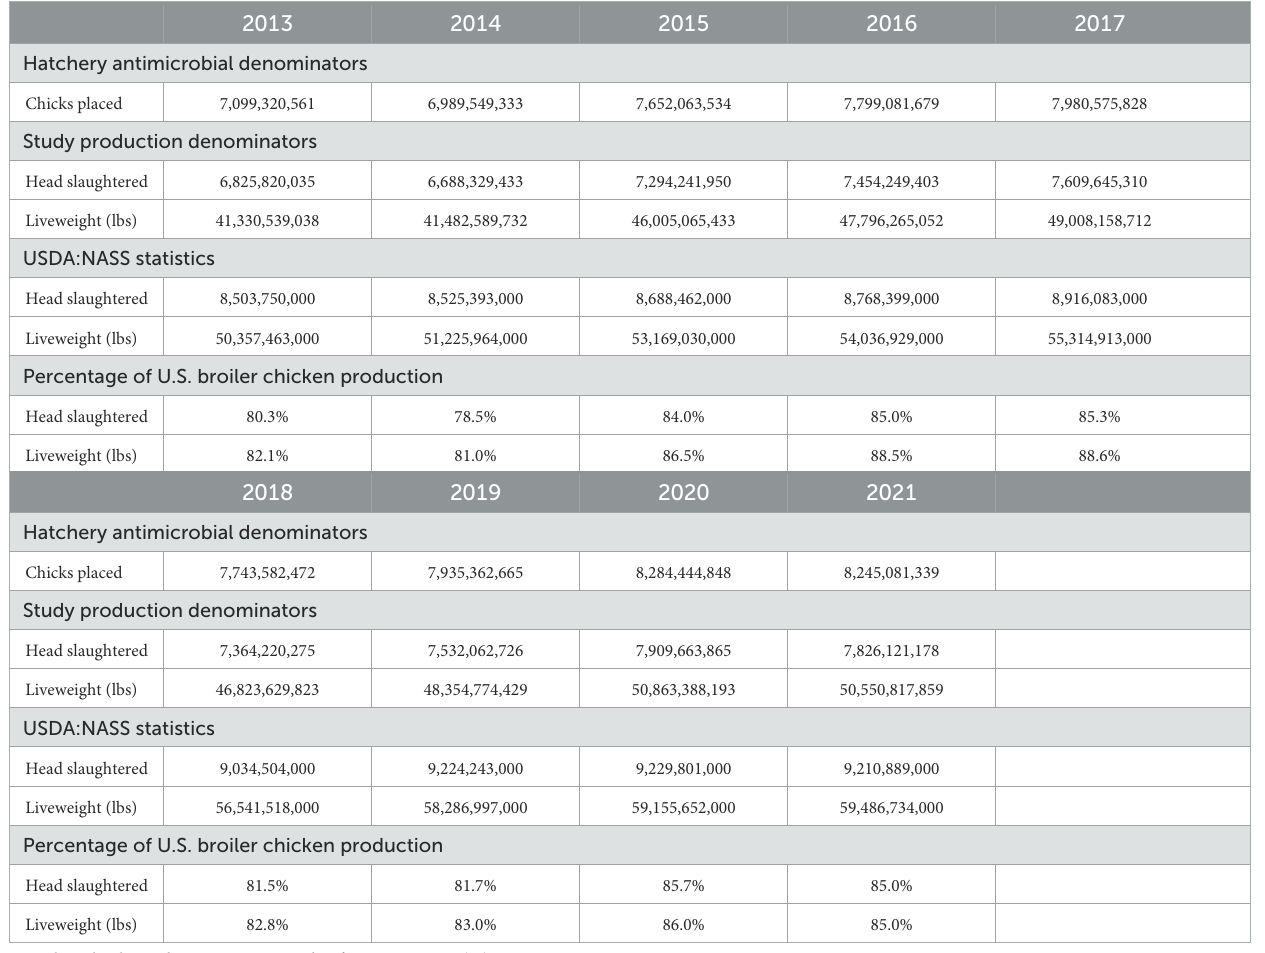
TABLE 1 Broiler chicken production data included in the antimicrobial datasets submitted by participating companies for each year of the study.